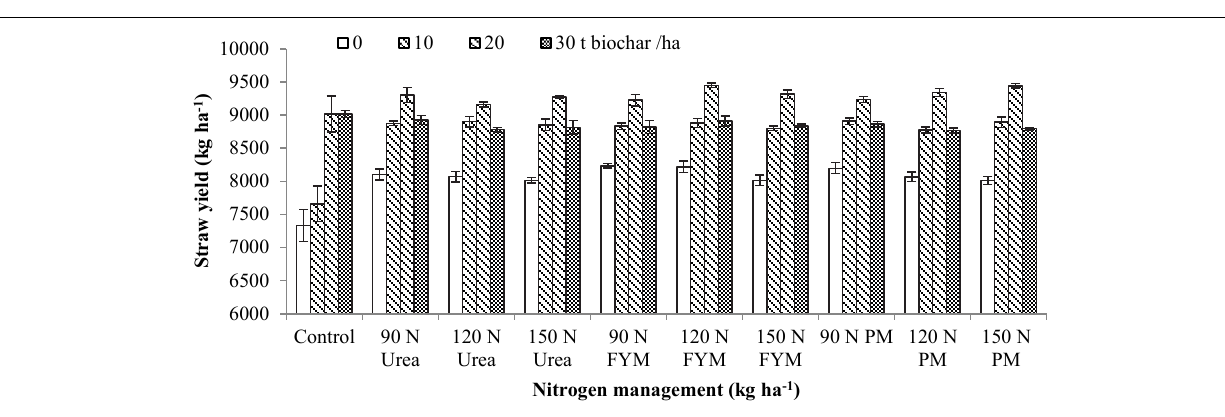
obtained at 120 kg N ha − 1 as FYM. This was followed by